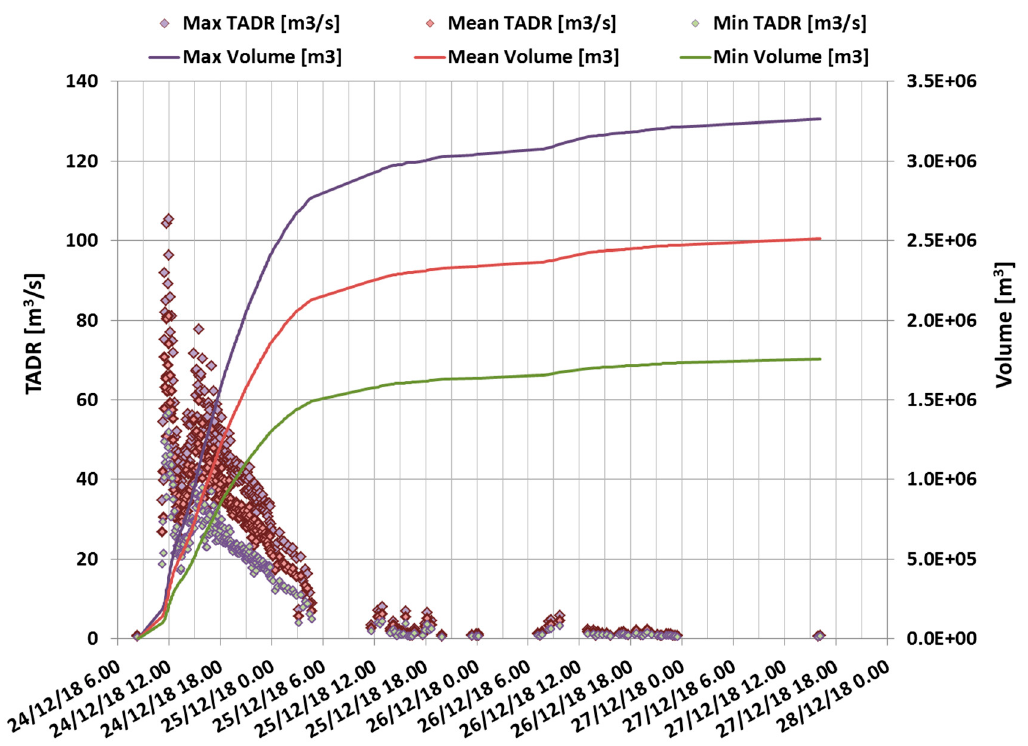
Figure 8. Time averaged discharge rate (TADR) and volume derived from the SEVIRI data processing over Etna. The first hotspot was detected on 24 December 2018 at 08:19, while the last hotspot was on 27 December 2018, 16:57.